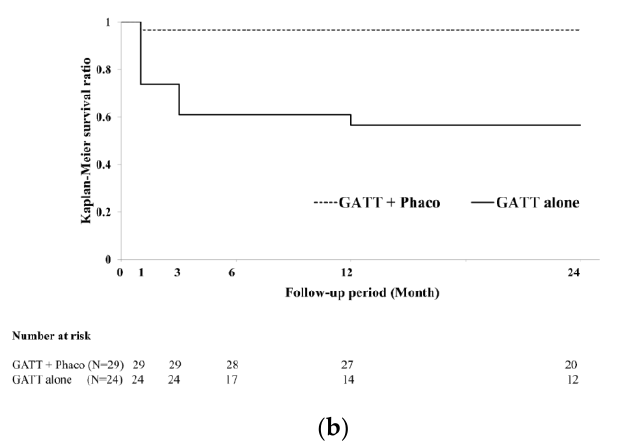
Figure 2. Kaplan–Meier survival curves of surgical success in the with phacoemulsification (solid line) and without phacoemulsification (dotted line) groups. ( a ) Survival curve in eyes that underwent CT with or without phacoemulsification. ( b ) Survival curve in eyes that underwent GATT with or without phacoemulsification. The GATT combined with phacoemulsification showed significantly higher surgical success rate than that without phacoemulsification (log-rank test, p < 0.001). CT, conventional trabeculotomy; GATT, gonioscopy-assisted transluminal trabeculotomy.